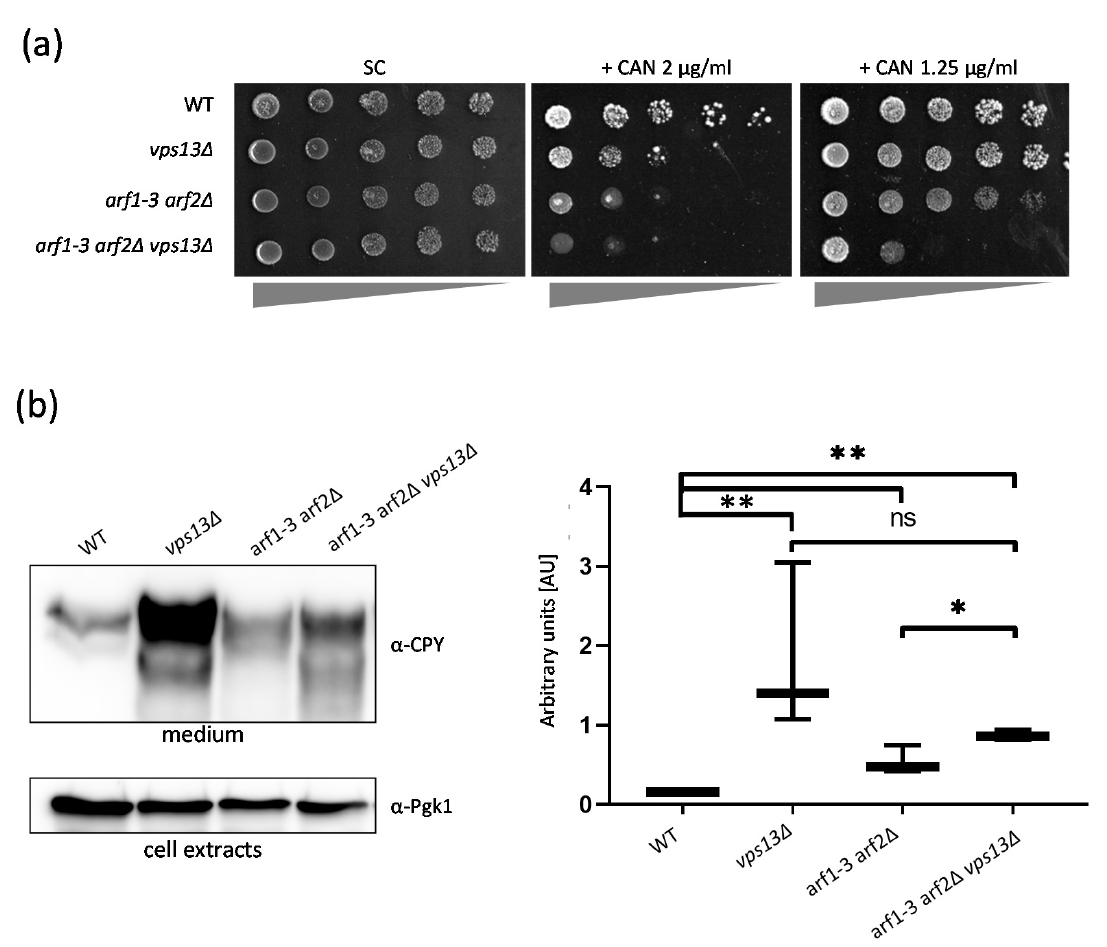
Figure 3. Vps13 and Arf1 proteins do not cooperate in endocytosis, but do cooperate in sorting proteins at the Golgi. ( a ) Sensitivity to L-canavanine (CAN) of WT and vps13 ∆ , arf1-3 arf2 ∆ , and arf1-3 arf2 ∆ vps13 ∆ strains. Serial (4 × ) dilutions of yeast cultures were spotted onto SC or SC-arg supplemented with CAN and incubated at 33 ◦ C for 5 days. ( b ) Vps13 cooperates with Arf1 in CPY sorting at the Golgi. Overnight yeast cultures were diluted to OD 600 0.5, cultured in YPD medium at 35 ◦ C for 1.5 h, and then harvested by centrifugation. The supernatants, containing secreted CPY, were concentrated on filters. Protein extracts from the cell pellets were obtained to determine the Pgk1 level (used as a control for the number of cells). Both fractions were analyzed by Western blot using α -CPY and α -Pgk1 antibodies. Experiments were performed in triplicate. Densitometry analysis of the blots was performed and presented in graphical form; (AU)—arbitrary units. Test- T : ns—non-significant; * p < 0.05; ** p < 0.01.